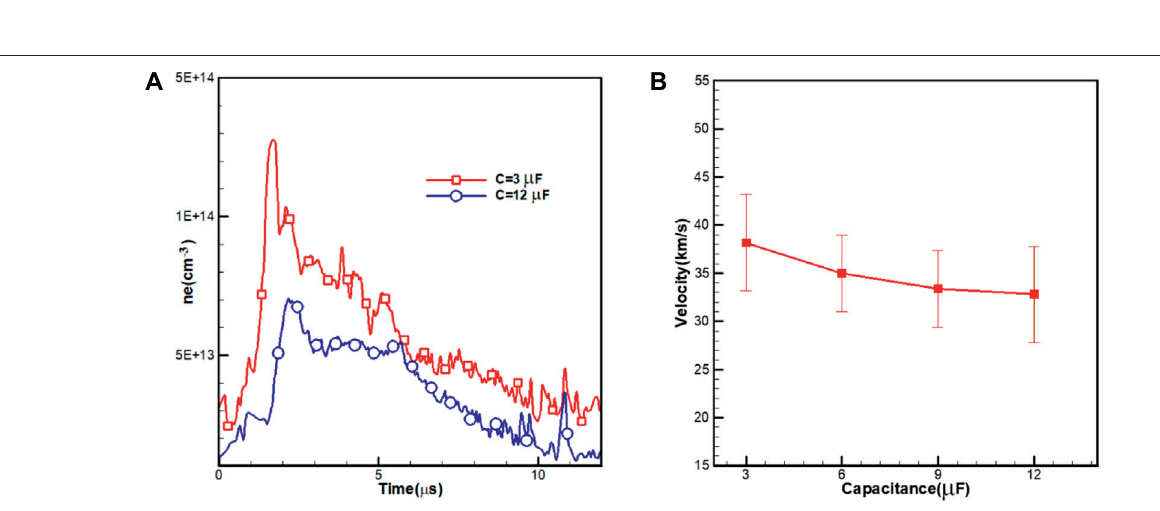
FIGURE 10 | Plasma characteristics under different capacitance and voltage con fi gurations, (A) plasma electron density, and (B) plasma velocity.